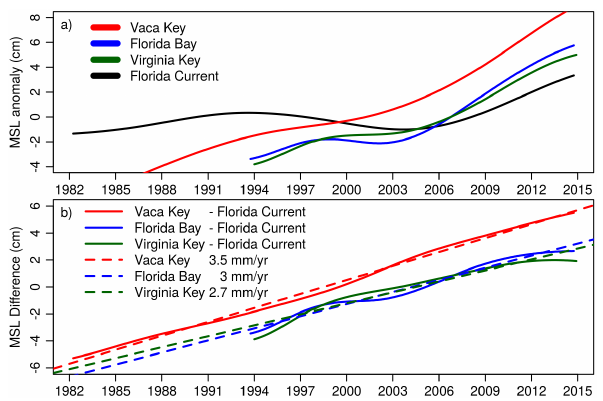
Figure 5. (a) MSL anomalies at Vaca Key, Florida Bay, and Virginia Key from EMD residuals, and for the Florida Current at 27 ◦ N as- suming a MSL–transport rate of − 1.4cmSv − 1 . (b) Difference of the Florida Current MSL anomaly from the MSL anomalies at Vaca Key, Florida Bay, and Virginia Key. Dashed lines are linear regres- sions to the MSL differences.